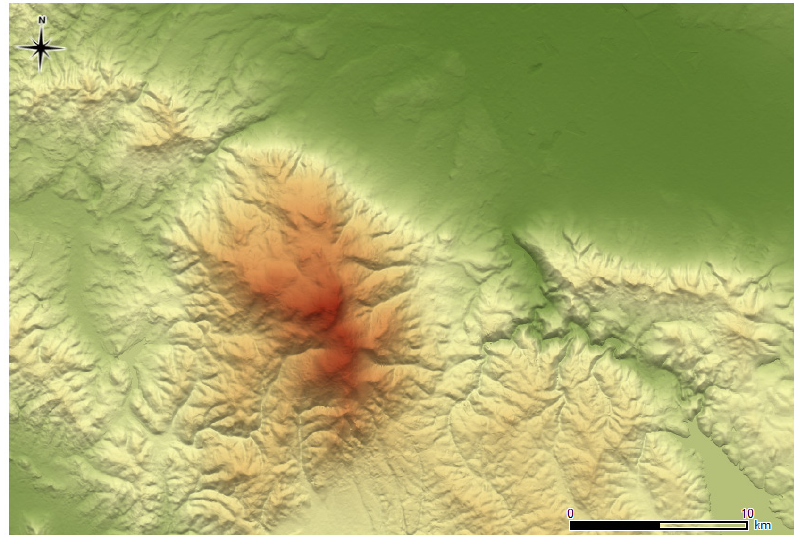
Fig. 7. Colour hypsometric tint with two-directional